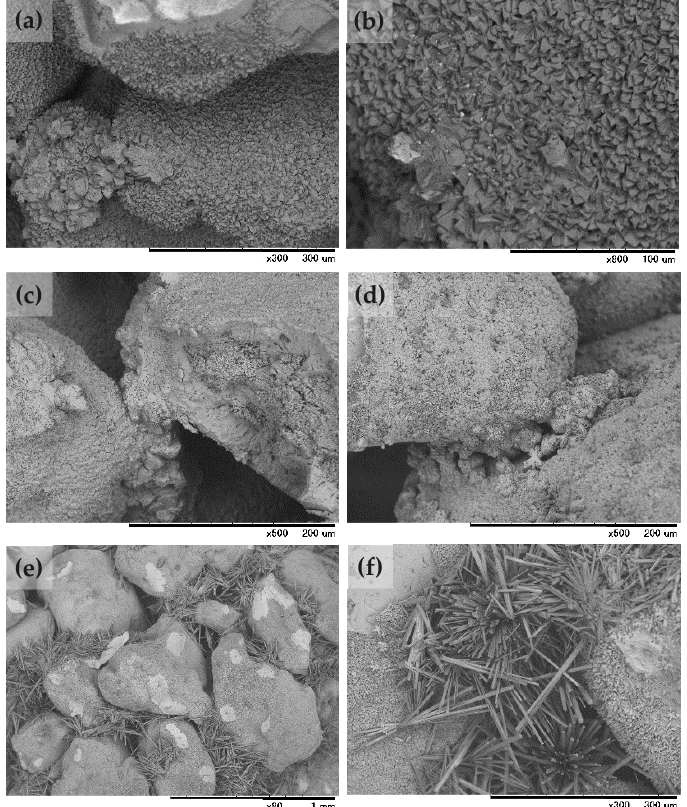
Figure 14. SEM images of variation in crystal morphology with different Mg 2+ /Ca 2+ molar ratios: ( a , b ) Mg 2+ /Ca 2+ = 0.00 and its closer view; ( c ) Mg 2+ /Ca 2+ = 0.25; ( d ) Mg 2+ /Ca 2+ = 0.43; ( e , f ); Mg 2+ /Ca 2+ = 1.00 and its closer view.